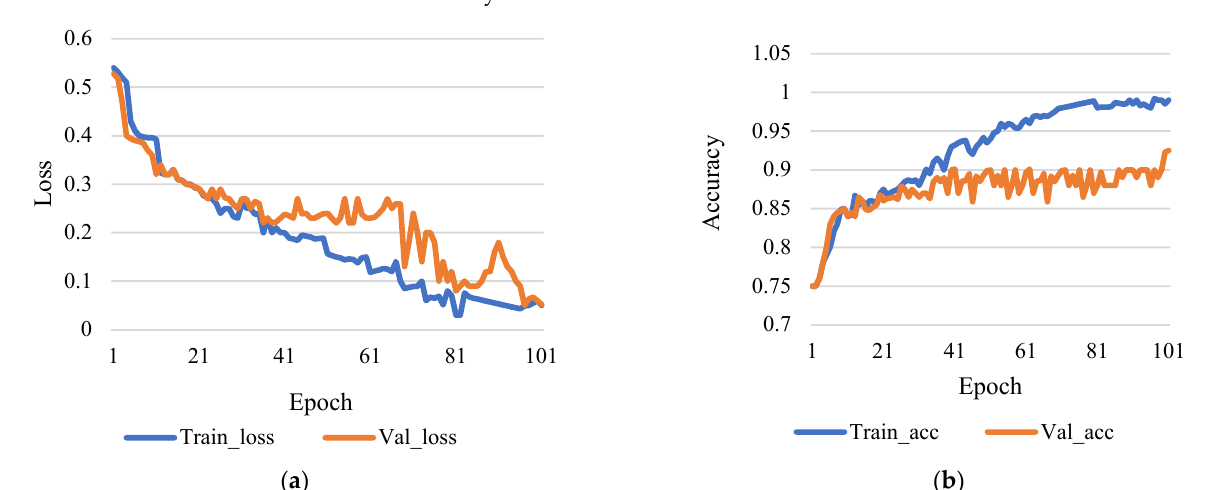
Figure 6. ( a ) Training loss vs validation loss (rate of learning 0.001 and epoch 50). ( b ) Training accuracy vs validation accuracy (rate of learning 0.001 and epoch 50).